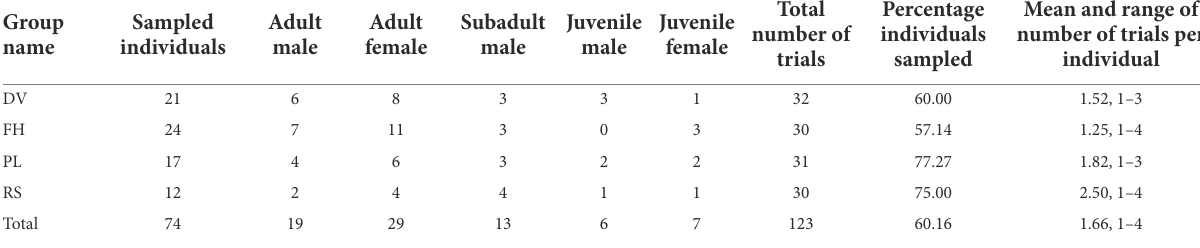
TABLE 2 Individuals (excluding infants), sampled during Task I, across the four study groups of bonnet macaques. Group